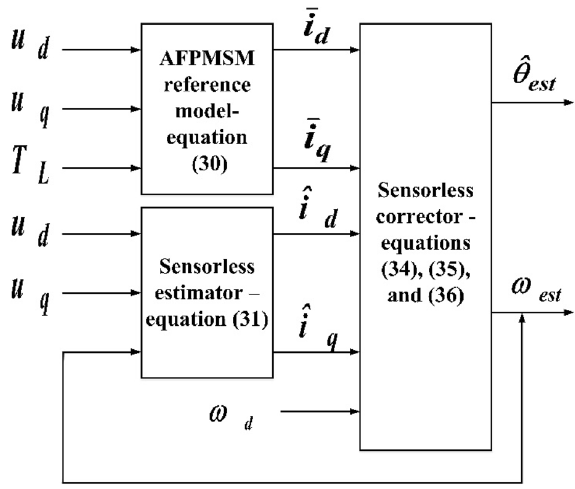
Figure 2. The proposed straight-line guided by the reference speed sensorless